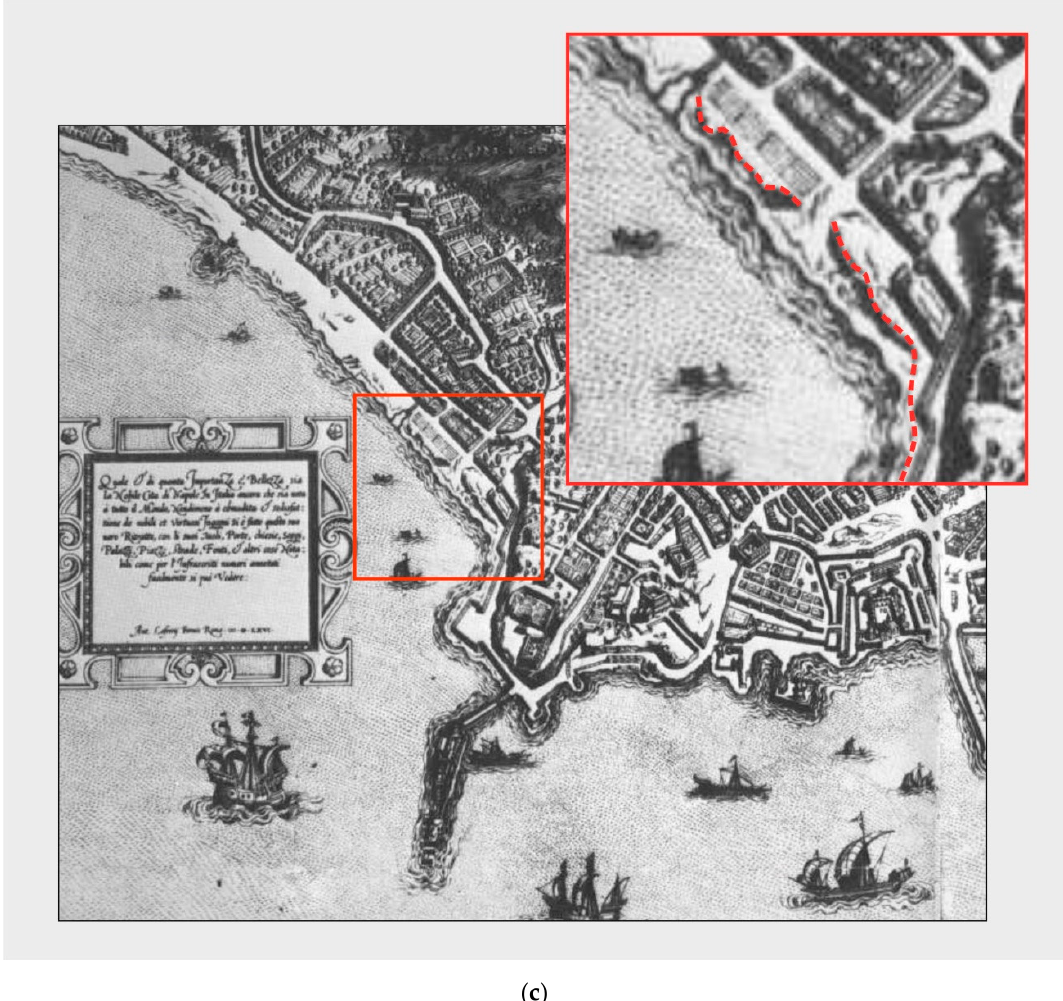
Figure 10. ( a ) Painting by Anton Sminck Pitlo 1820, view from S; ( b ) 1800’ painting, view from S; and, ( c ) Antony Lafrery (1566), map of Naples with the evidence of the uplifted terrace at Chiaia plain in the central part of the map.